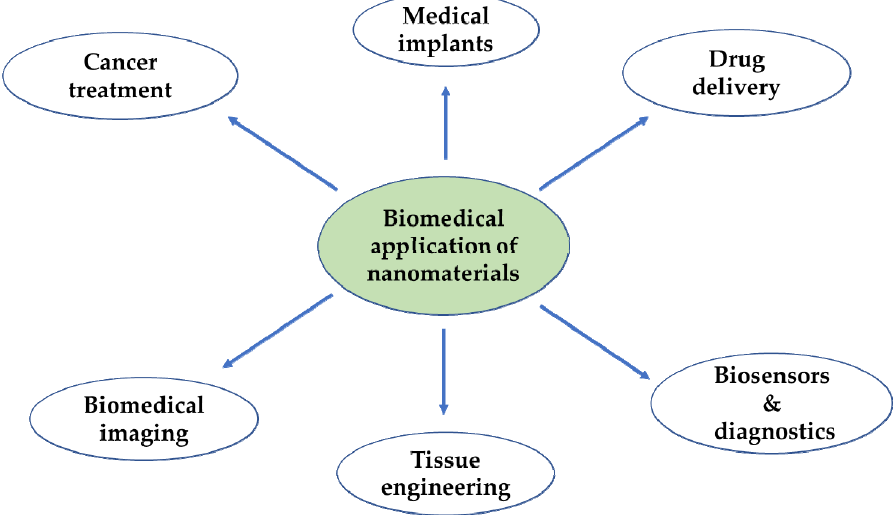
Figure 2. Application of the nanomaterials in the biomedical field.